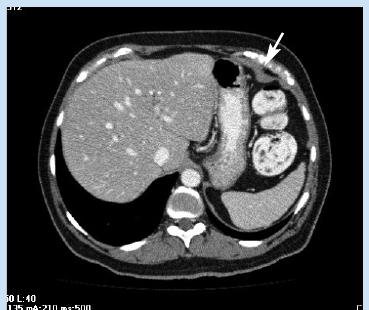
Fig. 6. The anterior diaphragm can look quite thick as it becomes continuous with the ante- riolateral diaphragm.